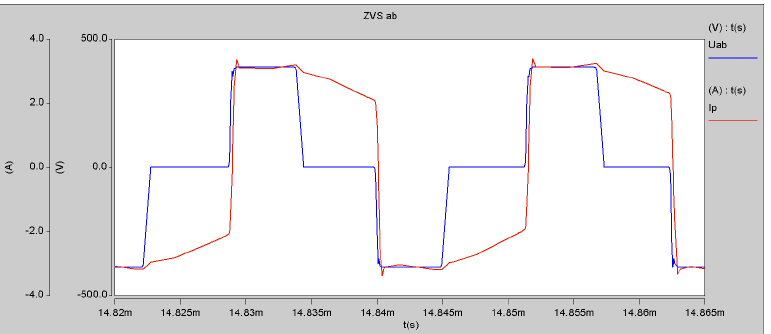
Figure 15. The voltage between the midpoints of the two legs of the H-bridge and the current waveform of the resonant inductor.